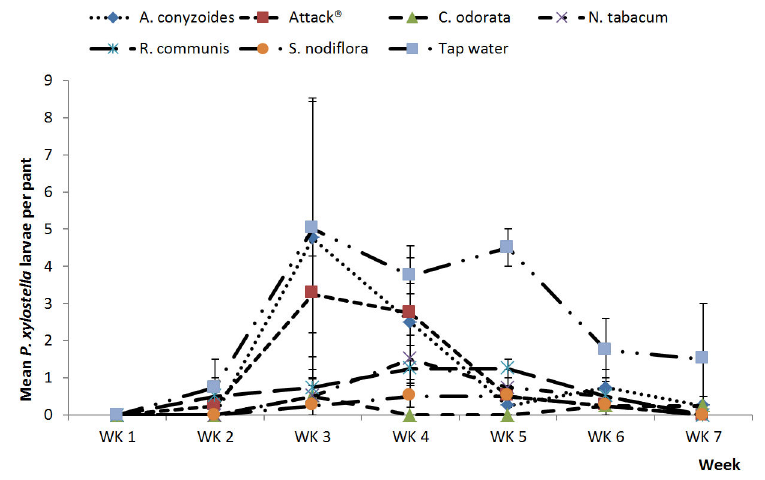
Figure 2. Plant extracts on P. xylostella , minor season. Effects of plant extracts and synthetic insecticide on mean (±SE) Plutella xylostella count in a field experiment during the minor rainy season, 2012 at Kumasi, Ghana.